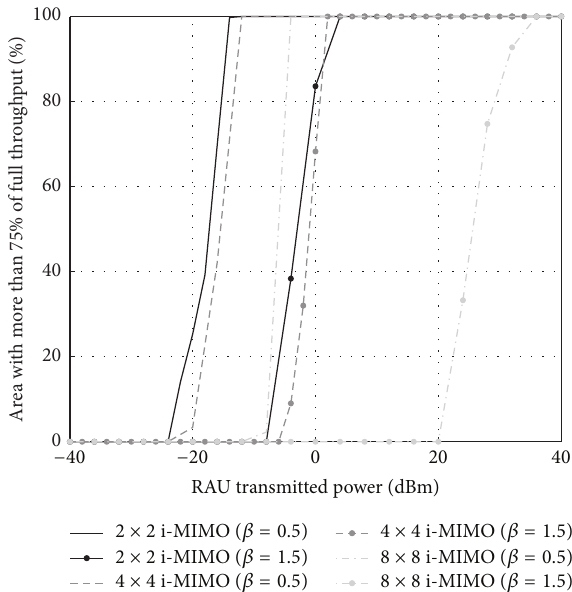
Figure 12: Comparison of 2-, 4-, and 8-branch i-MIMO DAS per- formance (% of area where more than 75% of maximum throughput is achieved) in the 2D deployment case, for different values of the propagation model parameters (RAU antenna distance: 20 m).